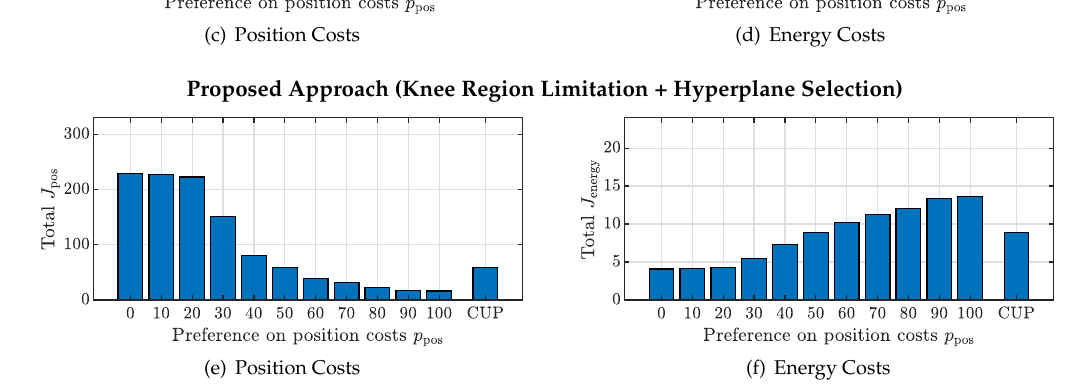
Figure 8. Position and energy costs for the rocket car example with different preferences p pos and p energy for ( a , b ) the simple baseline approach, ( c , d ) the simple baseline approach but with limitation to the knee region, and ( e , f ) the proposed preference-based decision making approach, with r lim = 0.85 for the latter two cases. Results from using the closest to Utopia point (CUP) metric are plotted for